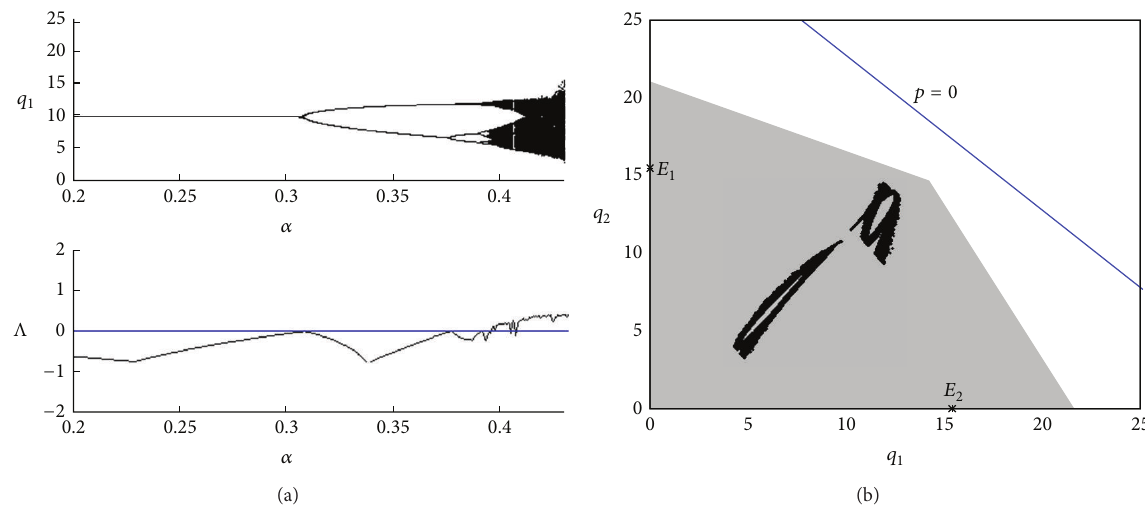
Figure 3: Parameter set: 𝑎 = 7.2 , 𝑏 = 0.22 , 𝑐 = 0.4 , and 𝛾 = 0.9 . (a) Bifurcation diagram of map 𝑀 1 and the corresponding Lyapunov exponent ( Λ ) for 𝛼 ∈ [0.2, 0.43] . The blue line 𝑝 = 0 represents points in which the market price equals zero. (b) Chaotic attractor for 𝛼 = 0.41 .